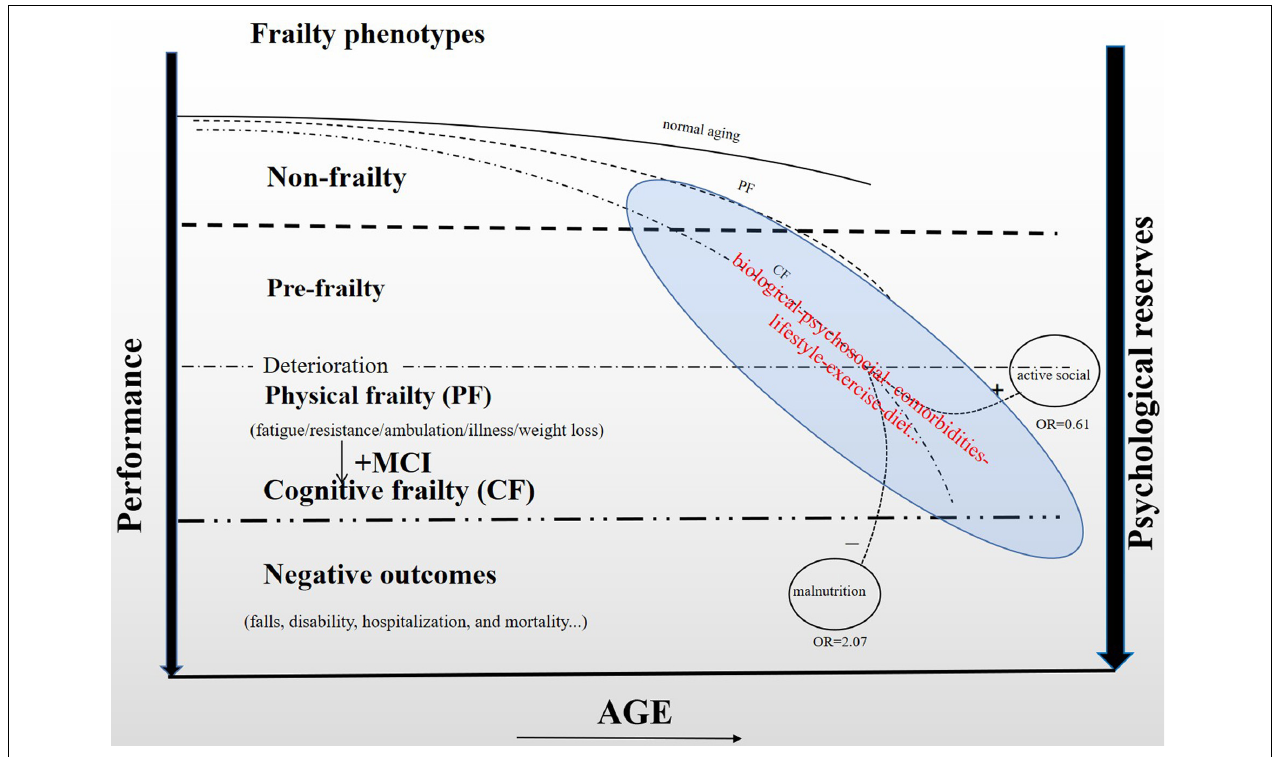
FIGURE 2 | Development of different frailty phenotypes with